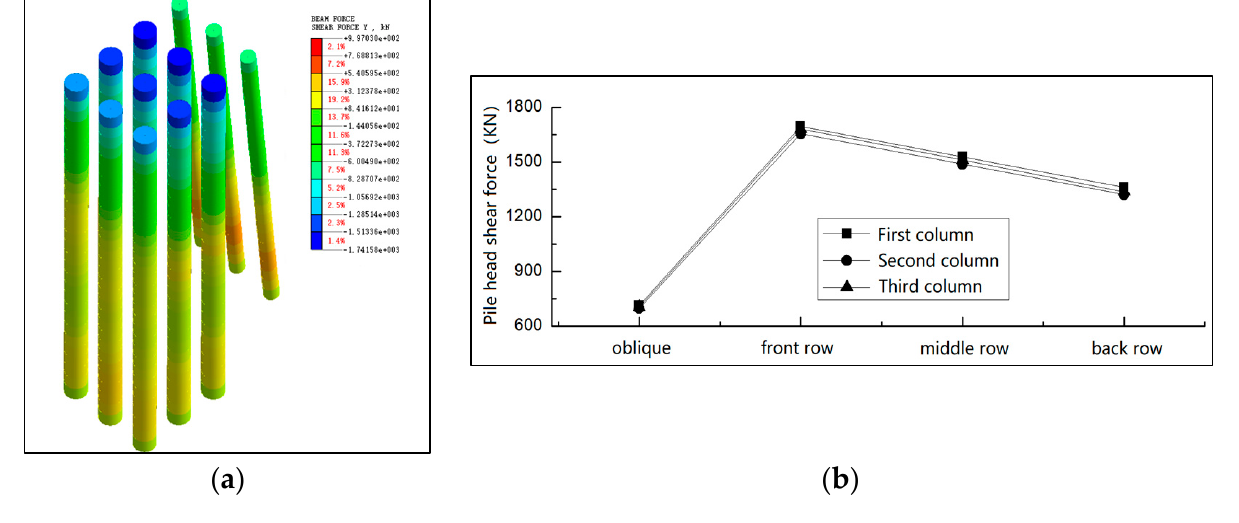
© Figure 13. Pile bending moment behavior: ( a ) first column; ( b ) second column; ( c ) third column.